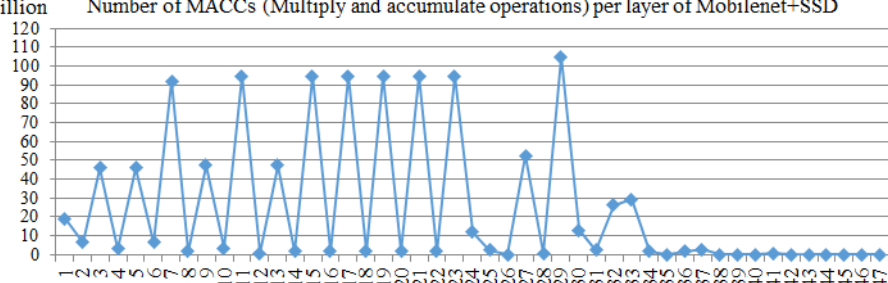
Figure 12. The calculation amount of MobileNet + SSD.